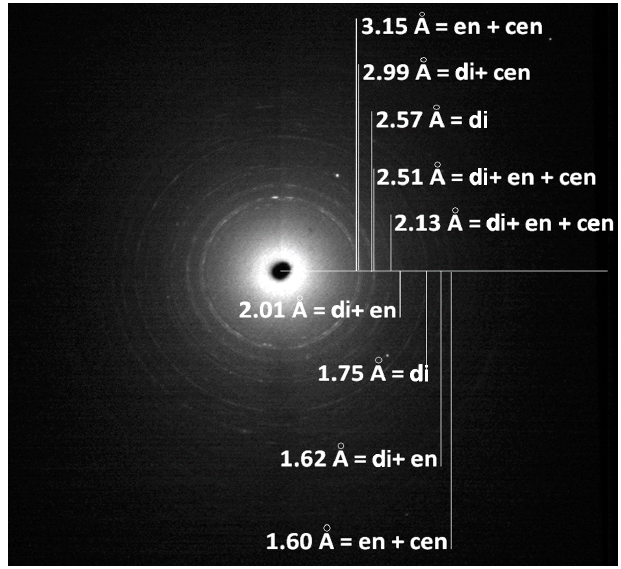
Figure 1. Interpretation of the nanodiffraction image collected on a tremolite fibre heated at 1000 °C showing the d ‐ spacings in Å of the major diffraction lines. Legend: di = diopside; en = enstatite; cen = clinoenstatite.